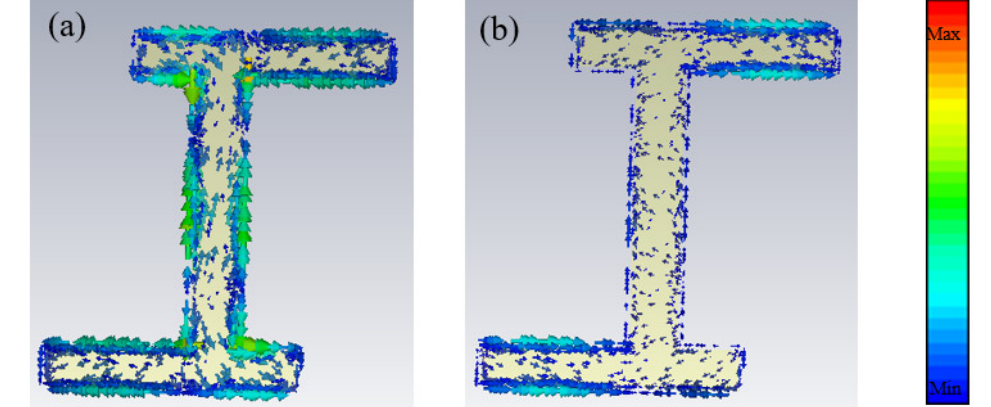
Figure 6. The distribution of induced currents at ( a ) low and ( b ) high resonant frequency.